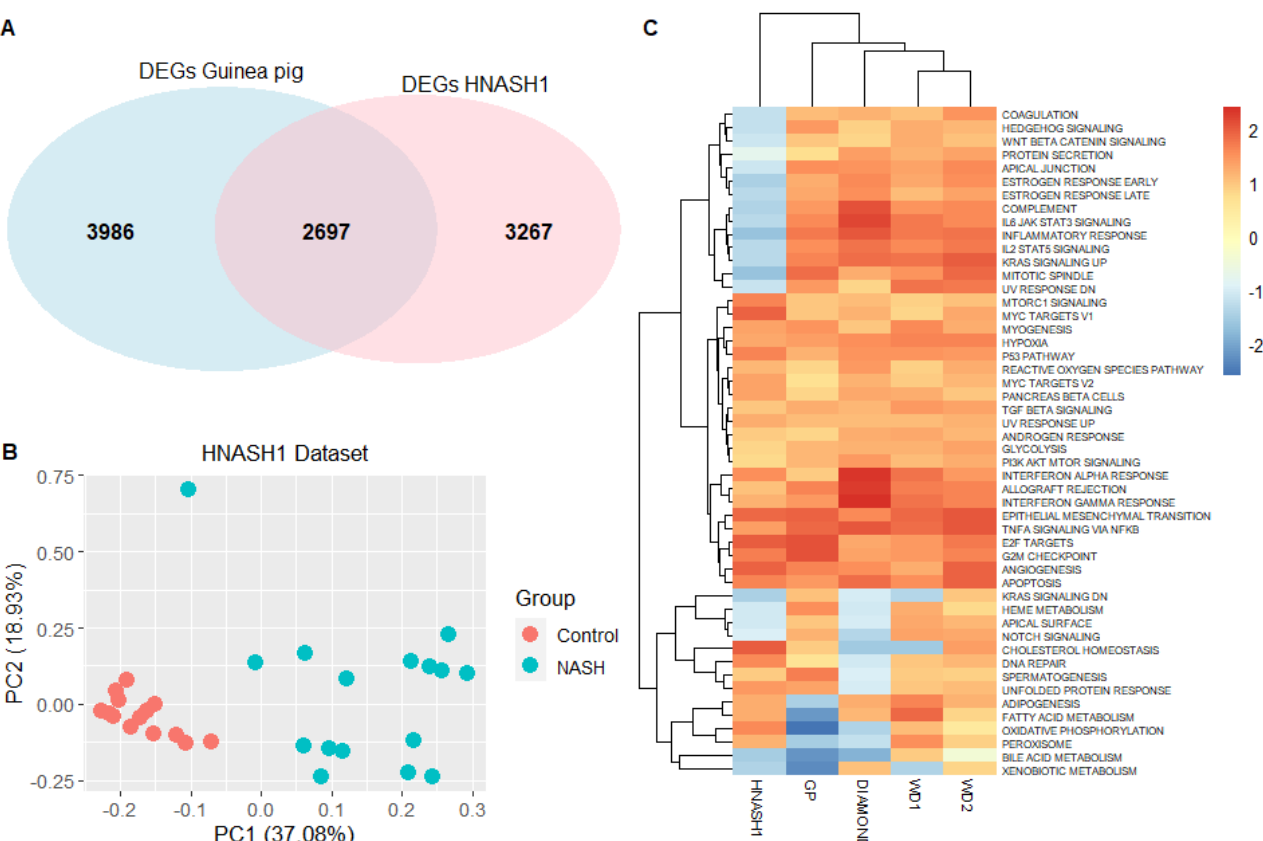
Figure 4. Comparison of preclinical models and patients with early-stage NASH. (A) Venn diagram of differentially expressed genes from HNASH1 (patients with mild disease vs. healthy controls) and guinea pig datasets, and their overlapping genes. Both datasets were analysed by DEseq2, and differentially expressed genes were selected on the basis of q < 0.05. ( B ) Principal-component analysis using top 200 differentially expressed genes in guinea pigs clearly separated patients with NASH from healthy controls in the HNASH1 dataset. Top 200 differentially expressed genes were selected on the basis of q < 0.05 and highest absolute log2 fold-change values. ( C ) Heatmap demonstrating overlap in expression patterns of Hallmark pathways. The heatmap is based on normalised enrichment scores from gene set enrichment analysis of Hallmark pathways from each dataset, i.e., HNASH1, guinea pig, and the included murine datasets (WD1, WD2, and DIAMOND). Dendrogram depicts hierarchical clustering of groups according to normalised enrichment scores. Colour bar indicates normalised enrichment scores, blue indicates a downregulated gene set, and red indicates an upregulated gene set. WD1 refers to GSE52748, WD2 refers to GSE38141, HNASH1 refers to GSE126848, DIAMOND refers to GSE67680. GP: guinea pig, DEG: differentially expressed gene, PC: principal component, NASH: nonalcoholic steatohepatitis.